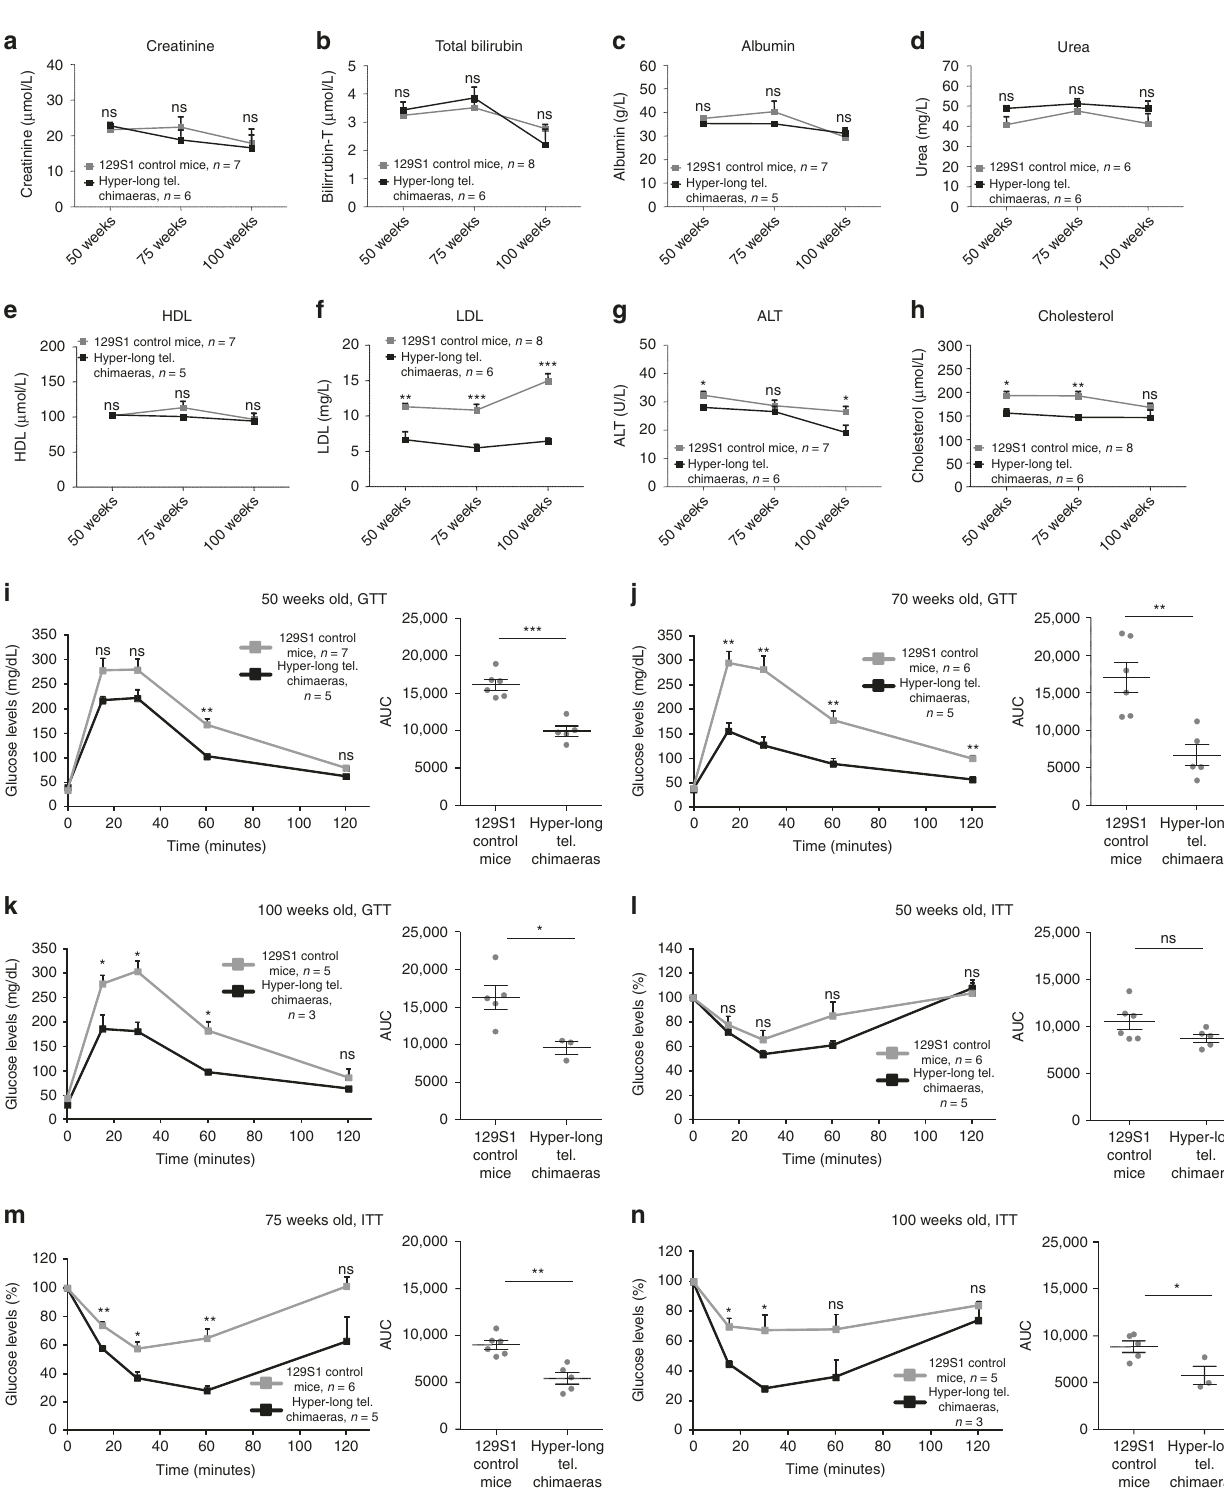
Fig. 3 Hyper-long telomere mice show less metabolic aging. a – h Pentra quanti fi cation of different serum metabolites at 50, 75, and 100 weeks-old. Metabolites were measured in serum obtained from blood extracts using ABX Pentra, a quanti fi cation of creatinine levels, b quanti fi cation of total bilirubin levels, c quanti fi cation of albumin levels, d quanti fi cation of urea levels, e quanti fi cation of HDL (high density lipoprotein) levels, f quanti fi cation of LDL (low density lipoprotein) levels, g quanti fi cation of ALT (alanine aminotransferase) levels and h quanti fi cation of cholesterol levels. i – k Glucose tolerance test (GTT). GTT was performed in hyper-long telomere mice and age-matched controls at 50 ( i ), 75 ( j ) and 100 ( k ) weeks of age by intraperitoneal glucose injection after 16 h fasting. l – n Insulin tolerance test (ITT). ITT was performed in hyper-long telomere mice and age-matched controls at 50 ( l ), 75 ( m ) and 100 ( n ) weeks of age by intraperitoneal insulin injection. Error bars represent standard error. t -test was used for statistical analysis. The number of mice is indicated in each case. * p < 0.05. ** p < 0.01. *** p < 0.001. Source data are provided as a Source Data fi